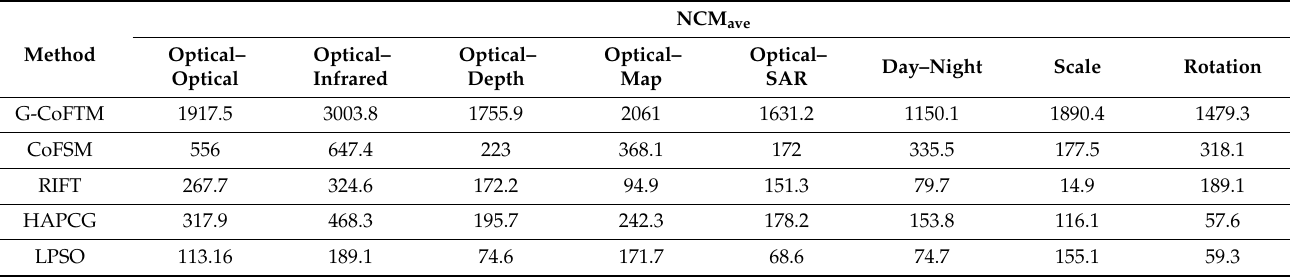
Table 6. Comparison on the NCM ave